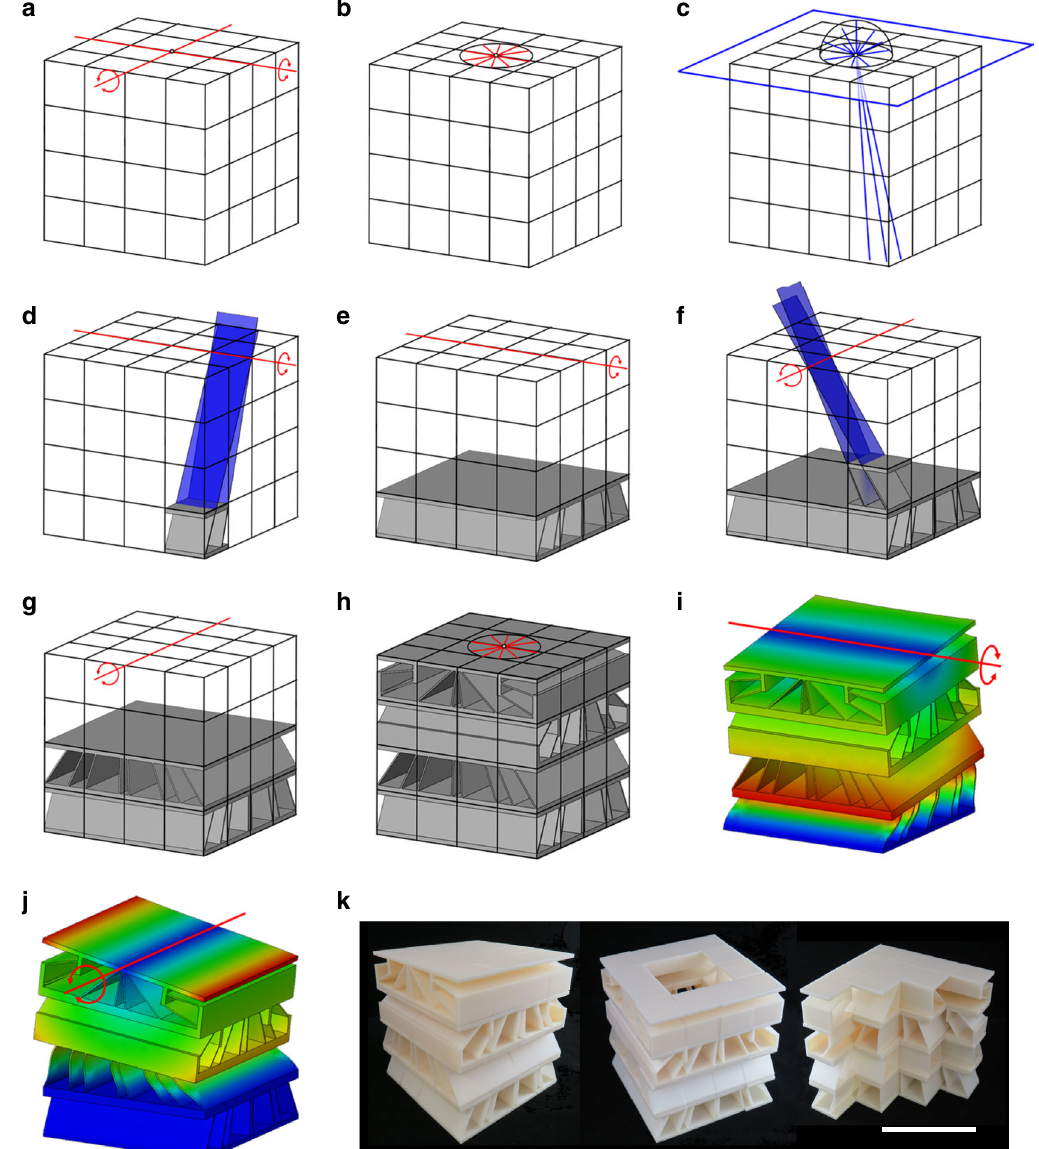
Fig. 6 Example with two intersecting rotational degrees of freedom (DOFs). a Two desired intersecting rotational DOFs and, b their freedom and, c constraint spaces. Since the plane of the constraint space doesn ’ t fi ll all space, two intermediate freedom spaces must be used. d The constraint space of the fi rst intermediate freedom space is used to synthesize the unit cells of, e the fi rst layer. f The constraint space of the second intermediate freedom space is used to synthesize the unit cells of, g the second layer. h This process is repeated for alternating layers until the fi nal directionally compliant metamaterial (DCM) is synthesized that, i , j achieves the desired DOFs. k The DCM can be additively fabricated and shaped as desired (scale bar in k , 10 cm, and colors in i and j are de fi ned in Fig.